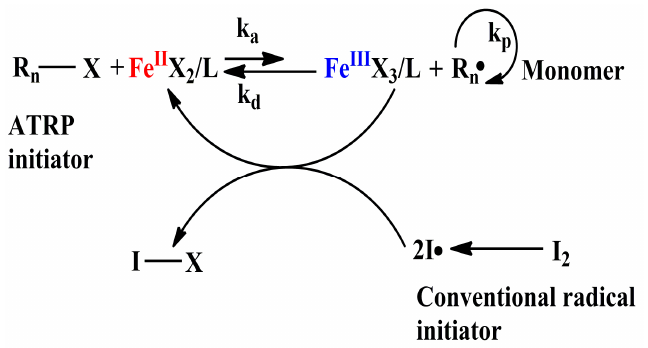
Figure 3. Mechanism of ICAR ATRP catalyzed by iron(III) catalyst.